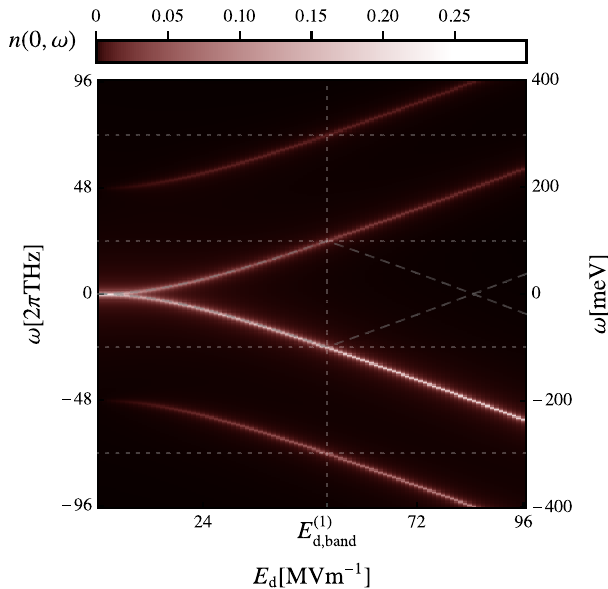
Fig. 3 Electron distribution at the Dirac point. The electron distribution n ( k = 0, ω ) at the Dirac point as a function of the driving fi eld strength E The driving frequency is ω d = 2 π × 48 THz ≈ 200 meV. The scaling behavior of the gap at the Dirac point is Δ where v F is the Fermi velocity. The vertical dotted line indicates E d ¼ E ð 1 Þ : The horizontal dotted lines indicate Floquet zone boundaries. The d ; band dashed lines show the Floquet energies at the Dirac point (See d Supplementary Note 1) that are formally constrained to be inside the fi rst Floquet zone. The occupations stay con fi ned within the Floquet bands adiabatically connected to the bare graphene and one replica outwards. There are no complementary gaps at k =